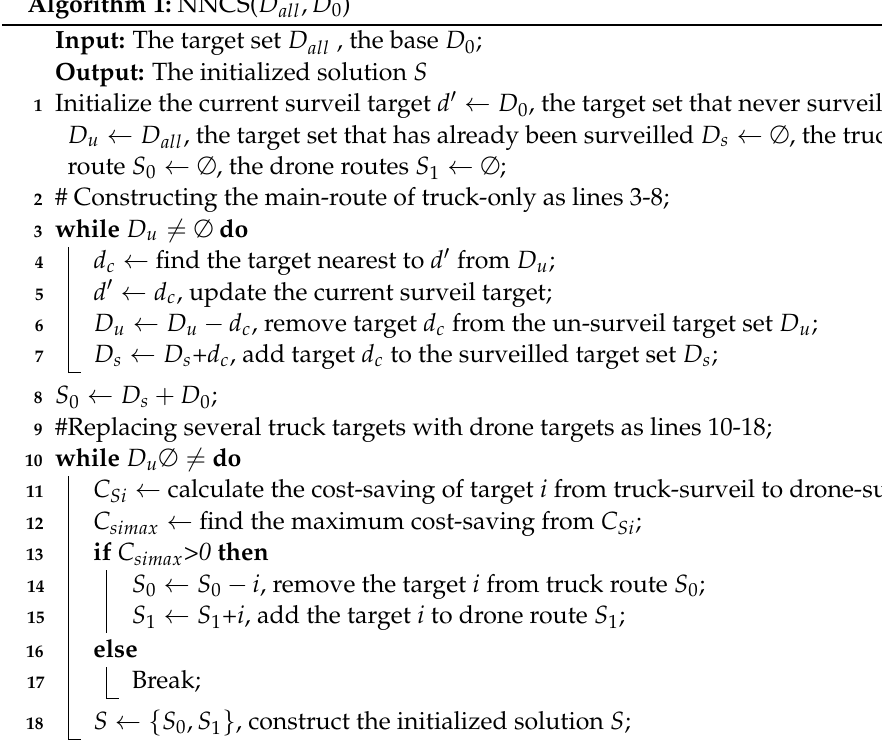
Algorithm 1: NNCS( D all , D 0